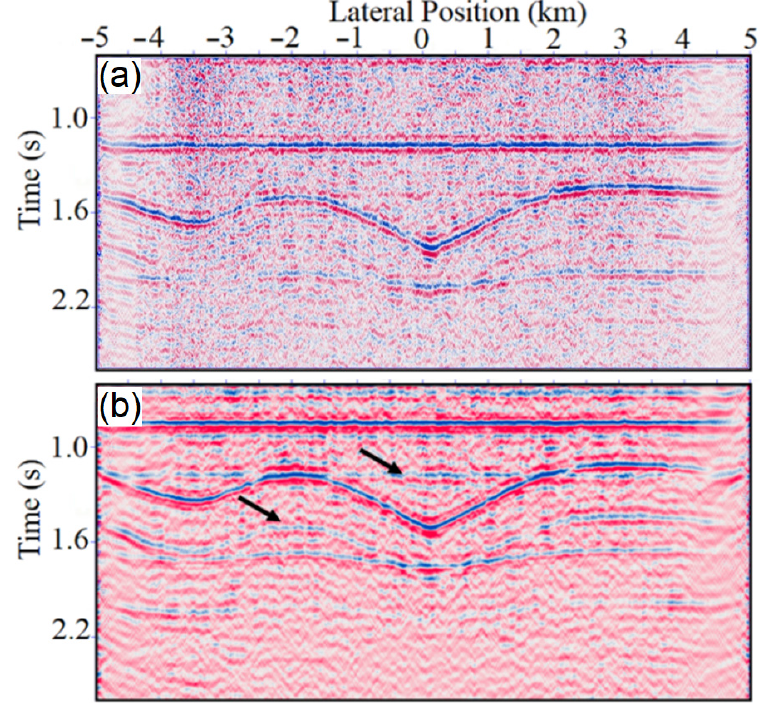
Figure 5. Stacked seismic section using geophones on ( a ) free surface and ( b ) beneath the attenuating weathered layer (Q = 30) corresponding to the geological model in Figure 3a,b. Arrows show downgoing surface multiples with the late arrival time of around 0.33 s comparing to their primary reflections.